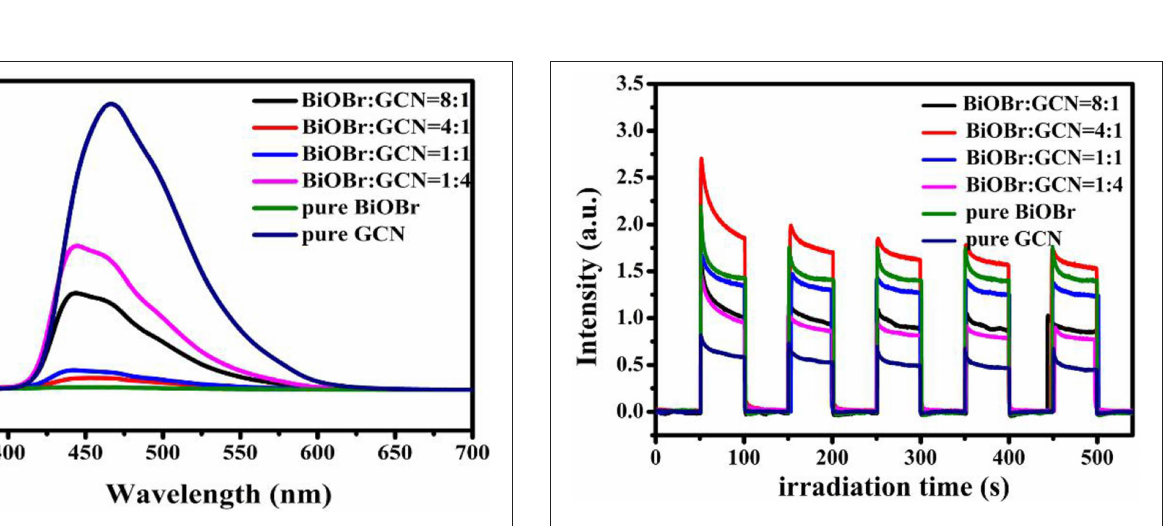
indicating that the low PL intensities of the BiOBr-g-C 3 N 4 composites did not originate from the lower amounts of g- C 3 N 4 , but originated from the formation of the heterojunctions, which suppressed the recombination of the photo-generated charges. The band structure of two components in the composite matched well, which impeded the rapid recombination of photogenerated carries within the semiconductors. The lower emission peak intensity, the less possibility in the recombination of photogenerated carries. Moreover, there is not any